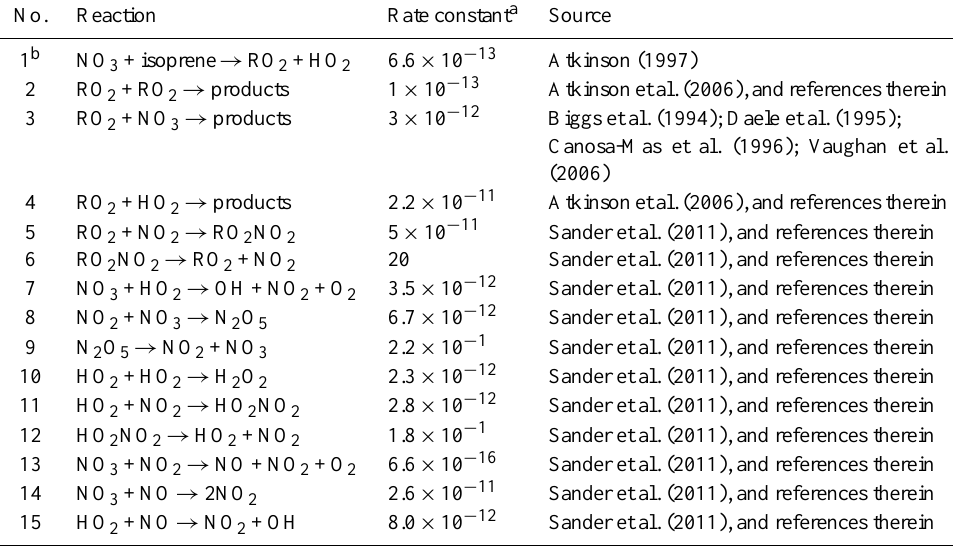
Table 2. Reactions considered for box model assessment of OH sources in the isoprene+NO 3 system. No.